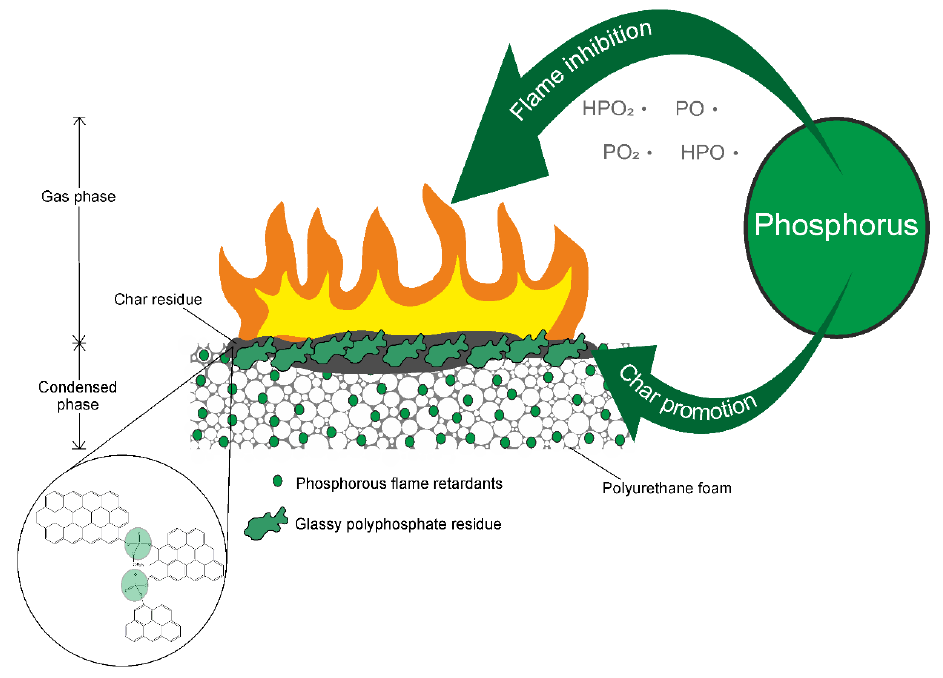
Figure 9. Modes of action of phosphorous flame retardants.